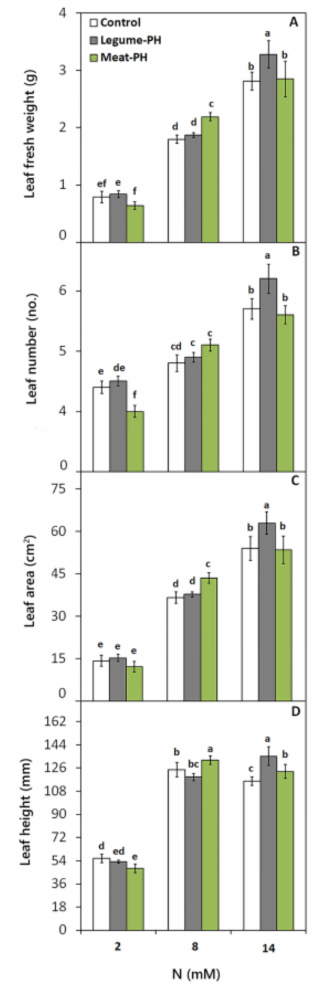
Figure 1. Effect of nitrogen doses and foliar application of biostimulants on fresh weight ( A ), number ( B ), area ( C ), and height ( D ) of spinach leaves. Vertical bars (standard error) ( n = 6) with different letters are significantly different according to the LSD test ( p =